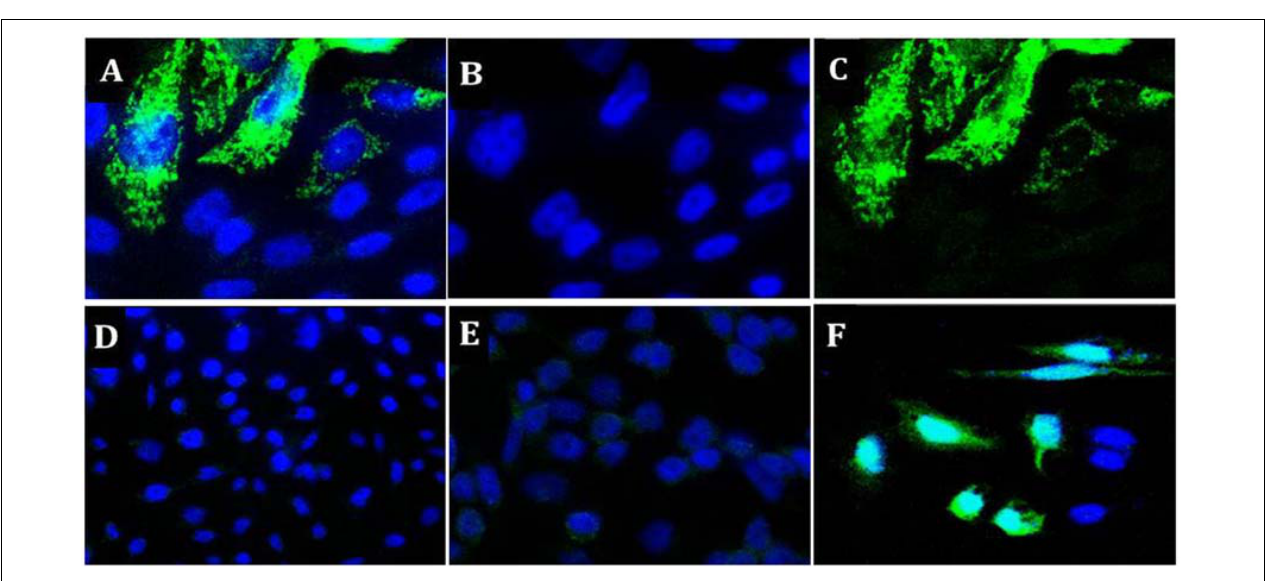
the pValac: Ag85A plasmid resulting in the recombinant invasive L. lactis FnBPA + (pValac: Ag85A )